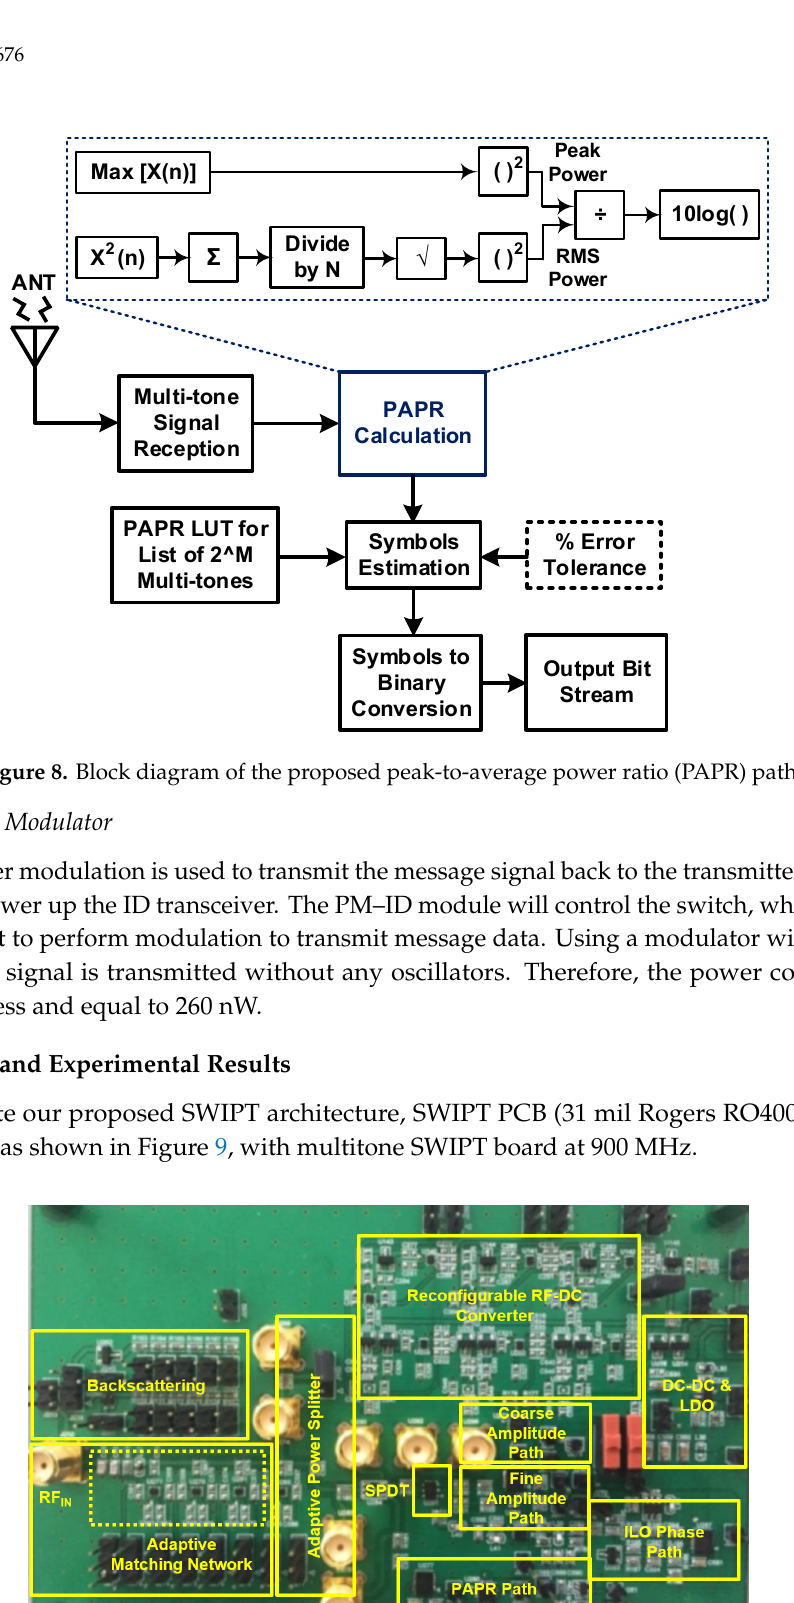
Figure 7. Operating principle of phase detection path. 304